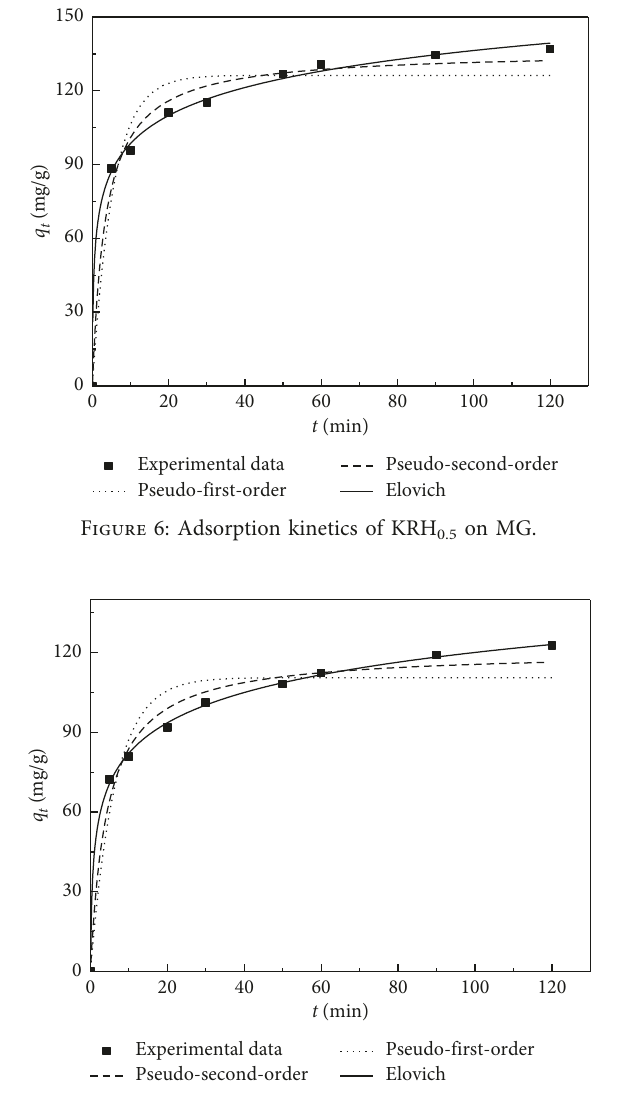
Figure 7: Adsorption kinetics of KRS